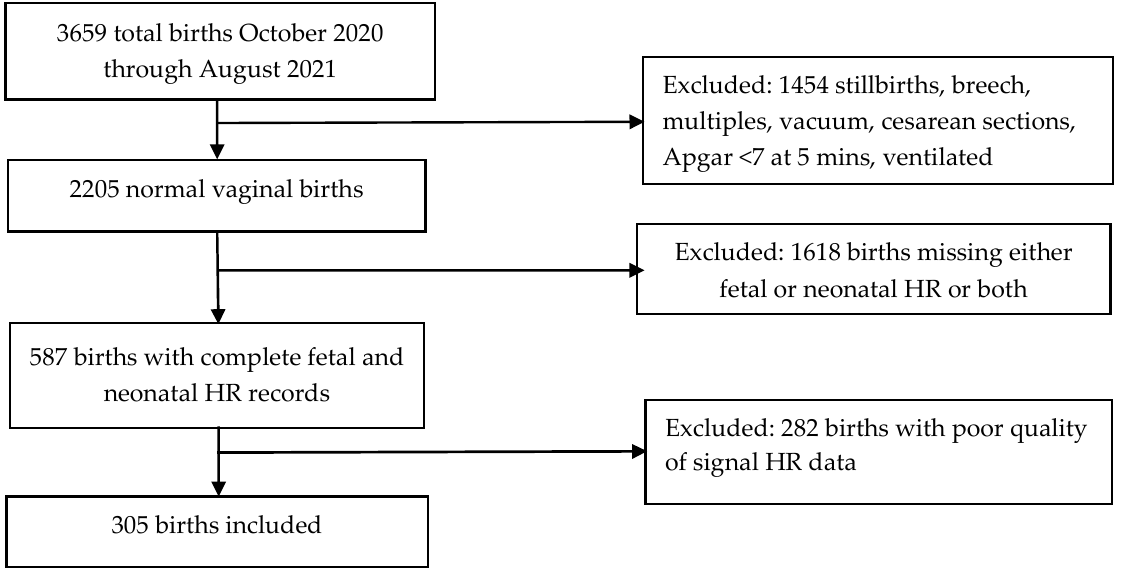
Figure 2. Flow diagram showing enrollment of participants. HR = heart rate. The number of individual HR observations varied at different time intervals. The max- imum was 198 individual observations recorded at 10 min before delivery and 303 recorded 3 min after delivery (Table 2). Table 1. Characteristics of participants. Table 2. Median heart rate at different time points and number of individual heart rate observations